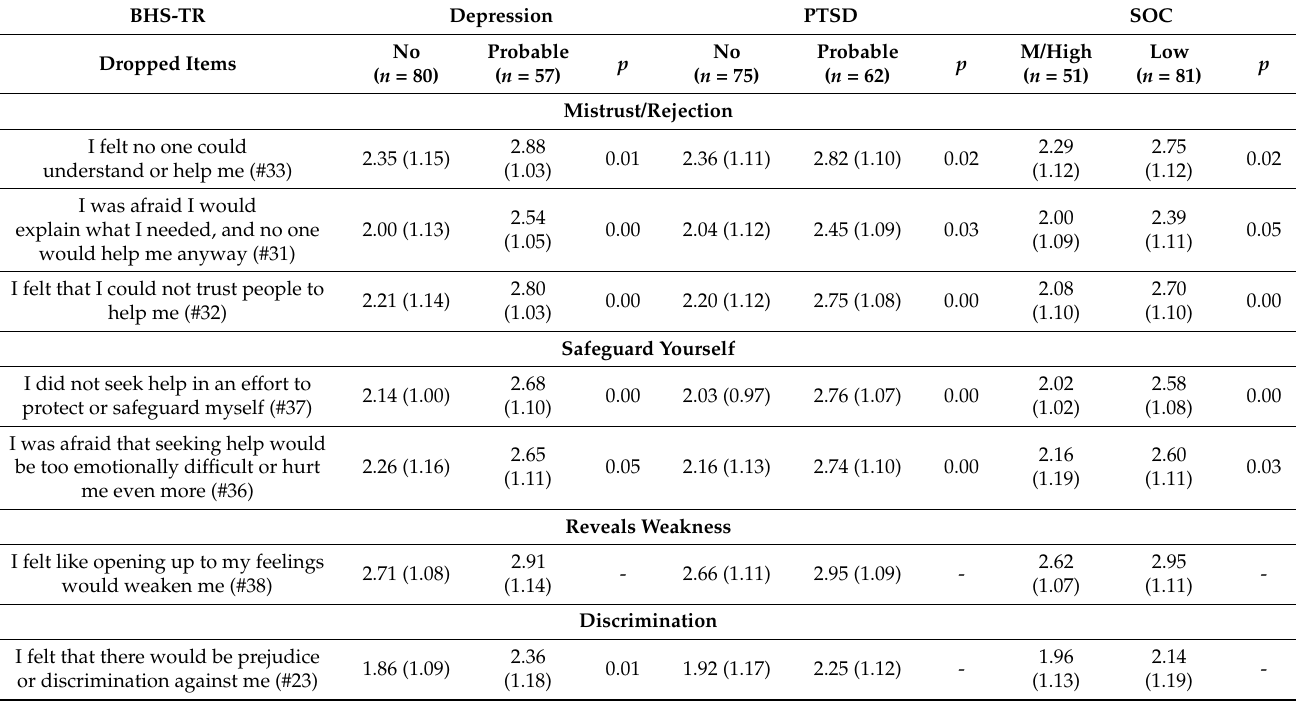
Table 6. Known-groups validity results on the item